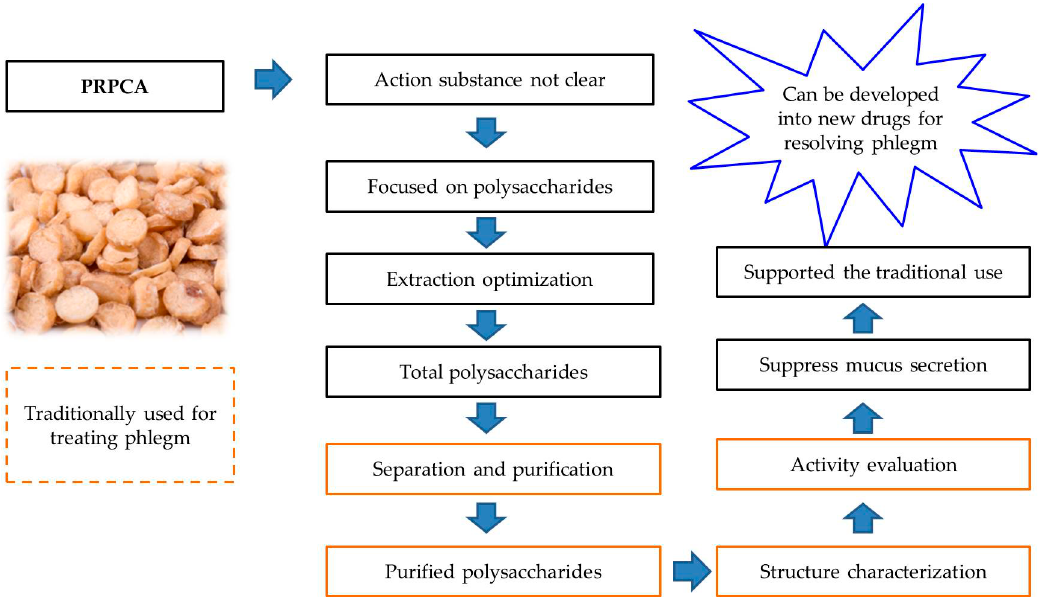
Figure 1. The research strategies of polysaccharides from Pinelliae rhizoma praeparatum cum alumine (PRPCA).